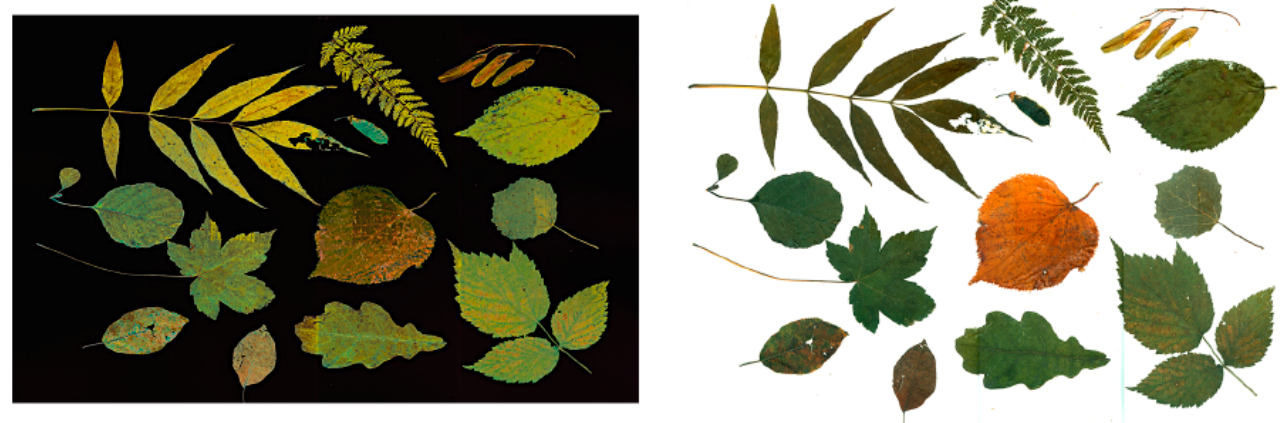
Figure 6. ‘Favourite tree leaves’, ( left ) a print and ( right ) plant specimens (Collins & Goto Studio 2019).